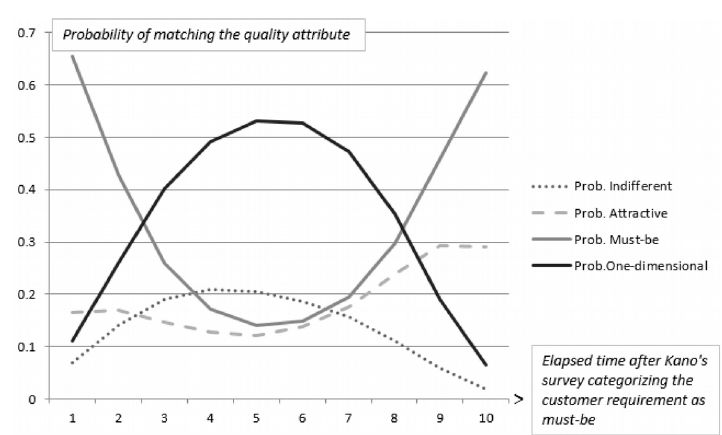
Figure 7. Expected trajectories of customer requirements designated as must-be